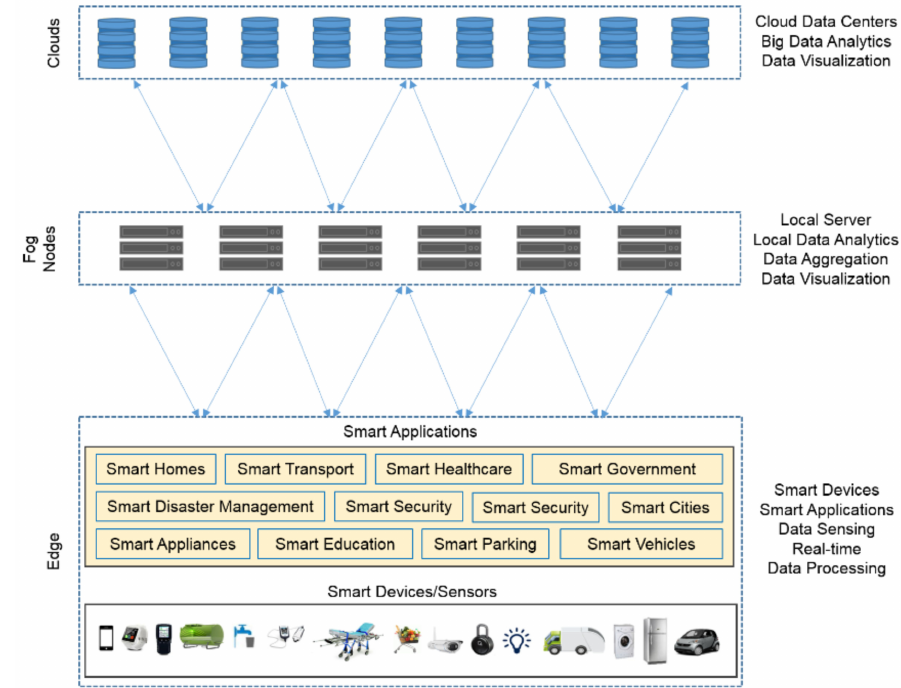
Figure 9. Edge and fog computing